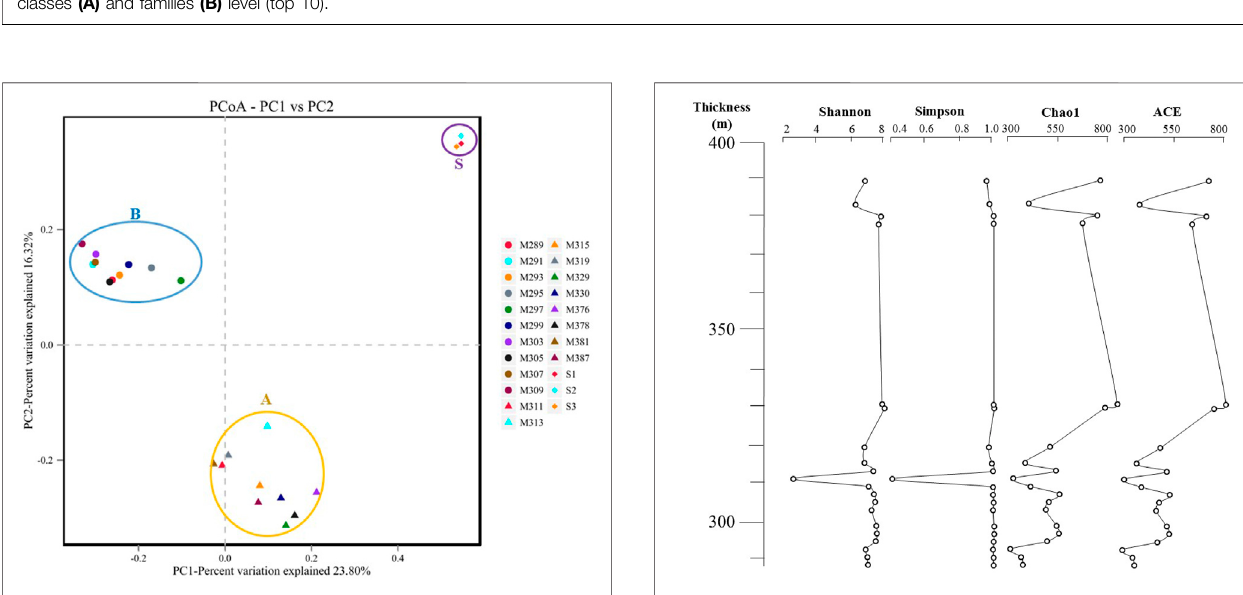
samples (yellow circle A: group A, blue circle B: group B, purple circle S: soil).